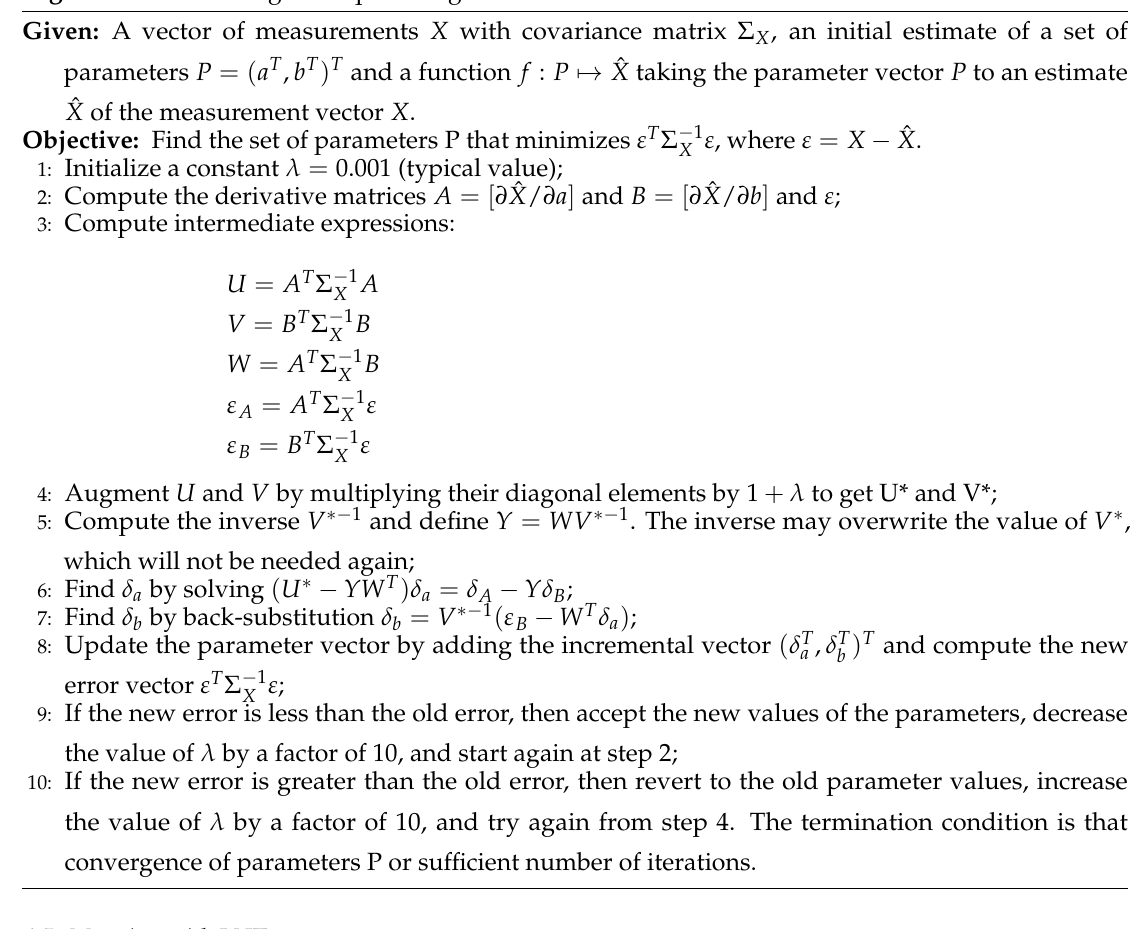
Algorithm 2 Levenberg − Marquardt